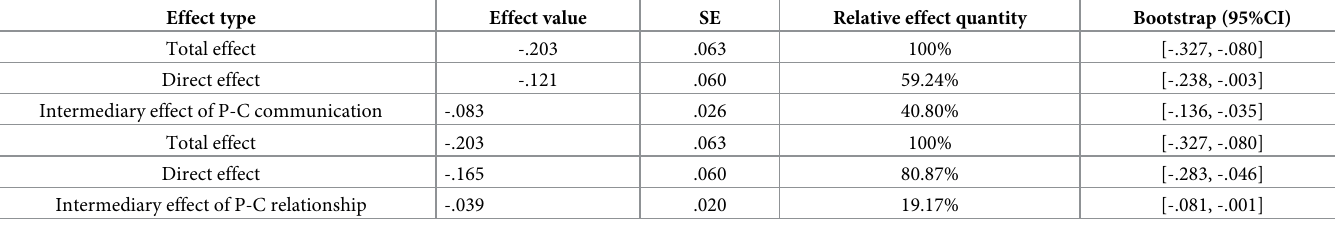
Table 4. Intermediary effect test of social support (family